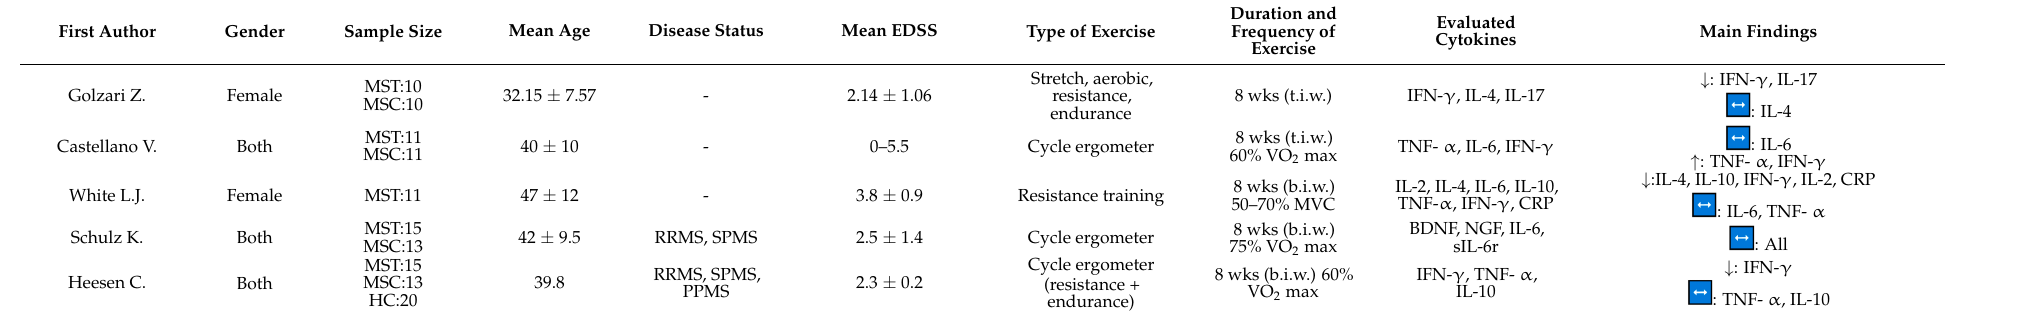
Table 2. Cont. Table 2. Sample characteristics and main findings of the reviewed studies. Table 2. Sample characteristics and main findings of the reviewed studies.